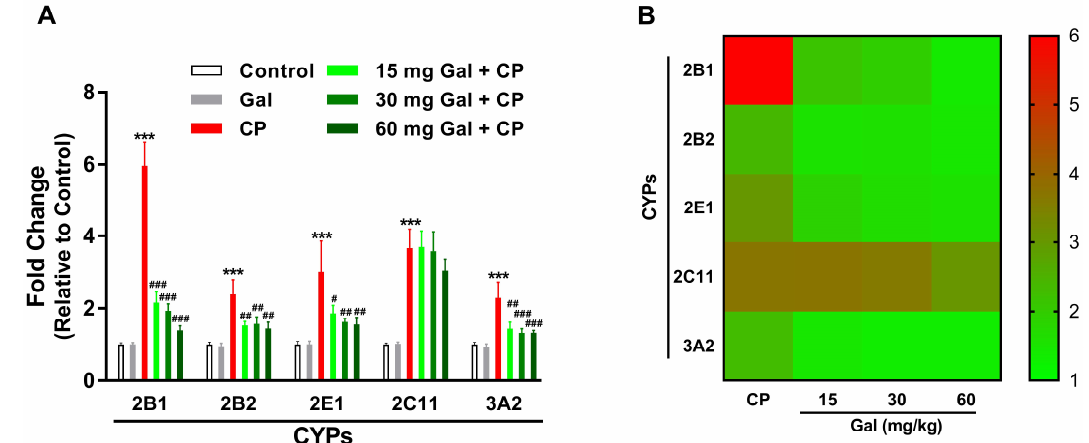
Figure 3. Galangin (Gal) prevents CP-induced alterations in the expression of cytochromes (CYPs). ( A ) Gal down-regulated CYPs 2B1, 2B2, 2E1, and 3A2 mRNA abundance in CP-induced rats. Data are mean ± SEM, ( N = 6). *** P < 0.001 versus Control, and # P < 0.05, ## P < 0.01, and ### P < 0.001 versus CP. ( B ) Heat map showing the effect of Gal on the expression of CYPs in CP-induced rats.